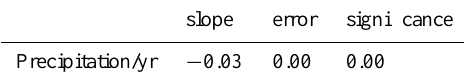
Table 6. Linear regression of precipitation